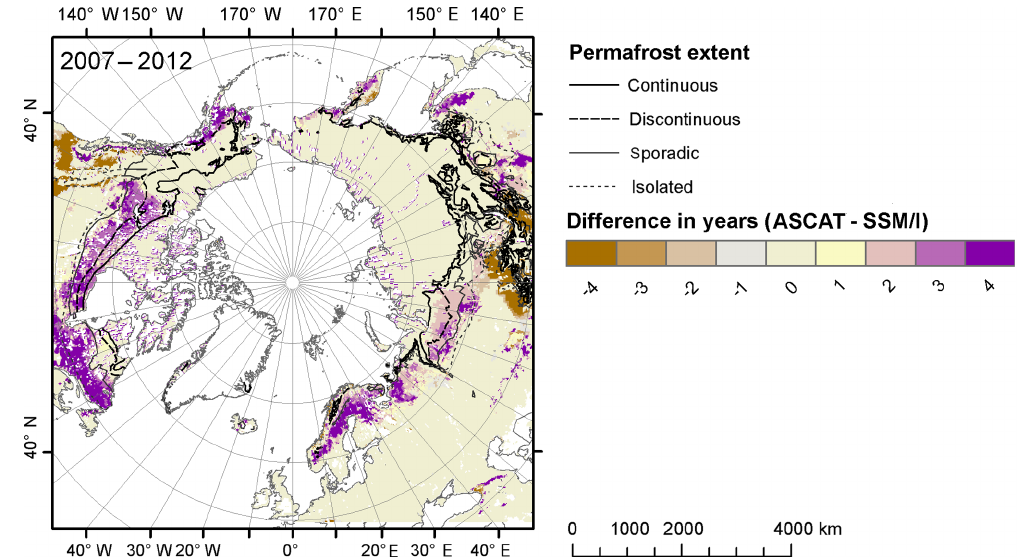
Figure 7. Comparison of the total number of years classified as permafrost between Metop ASCAT and SSM/I for 2008–2012 based on the